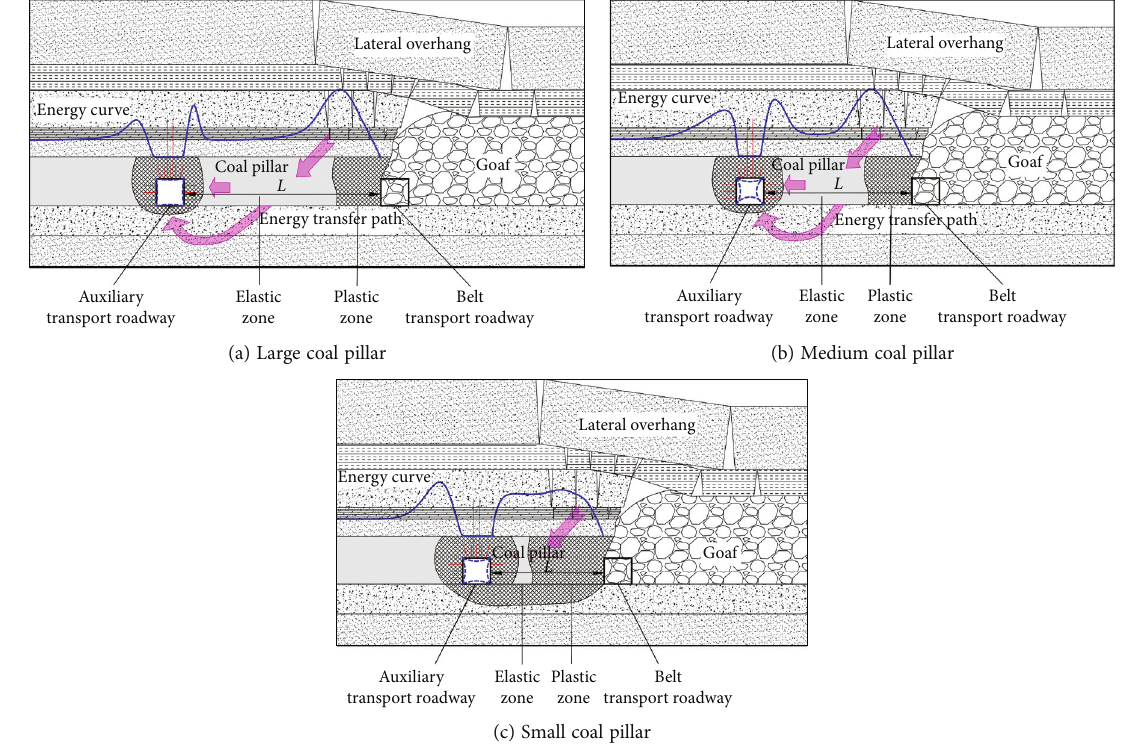
Figure 8: Deformation and failure characteristics of coal pillar roadways with di ff erent